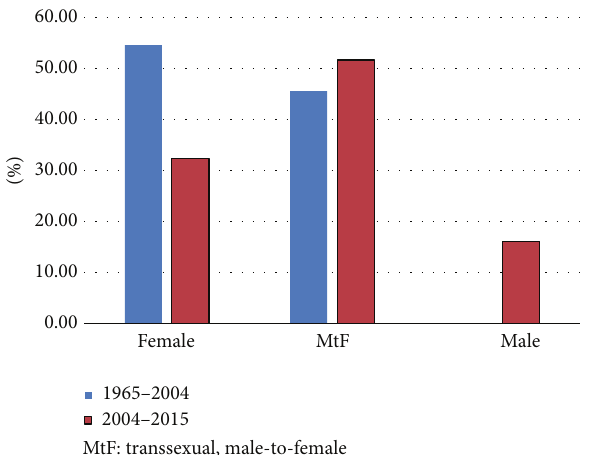
Figure 4: Difference in patient’s demographic analysis by gender between two time periods (1965–2004 versus 2004–2015).